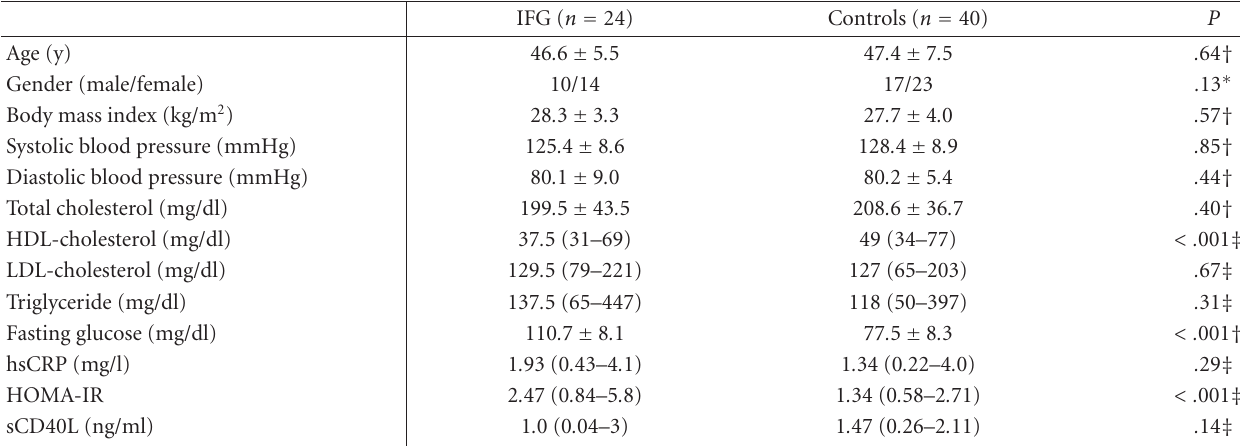
Table 1: Comparison of characteristics and laboratory findings of the subjects with IFG and healthy controls. Data are expressed as mean value ± SD, median (min-max).